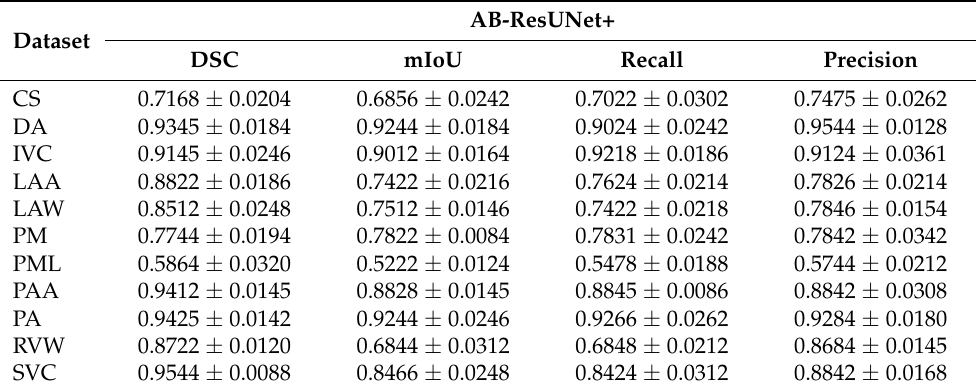
Table 6. Obtained segmentation results of different cardiovascular structures for AB-ResUnet+ network architecture.